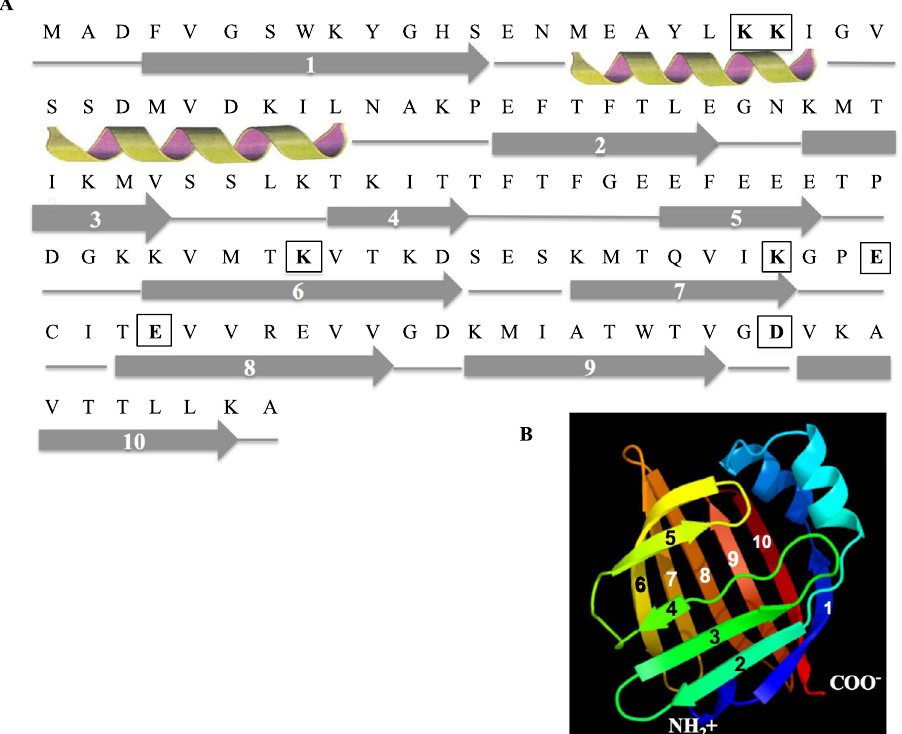
Figure 4. Prediction of secondary and tertiary structures of Fh15. ( A ) Secondary structures of Fh15 predicted by the SOPMA and ( B ) tertiary structure of Fh15 predicted by Phyre2. Both programs are available at ExPASy server (Bioinformatics Resources Portal, www.expasy.org). Fh15 contains two short alpha helixes (h) and a large content of extended strands (e) and random coils (c). Amino acid residues into boxes (K21, K22, K83, K97, E100, E104 and D122) are predicted to bind to the LPS-binding pocket on the human CD14 structure according previous studies 12